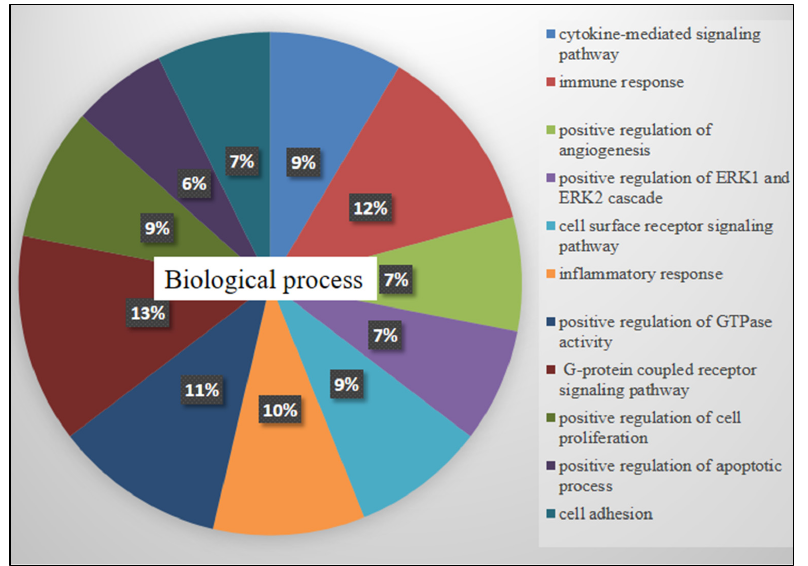
Figure 3. DAVID software analyzed the possible biological processes of the significantly affected genes in treated HL60 cells. Biological activation based on extracellular signals was highly affected after TQ treatment. The area of each category represents the percentages of involved genes to each other ( p < 0.05).